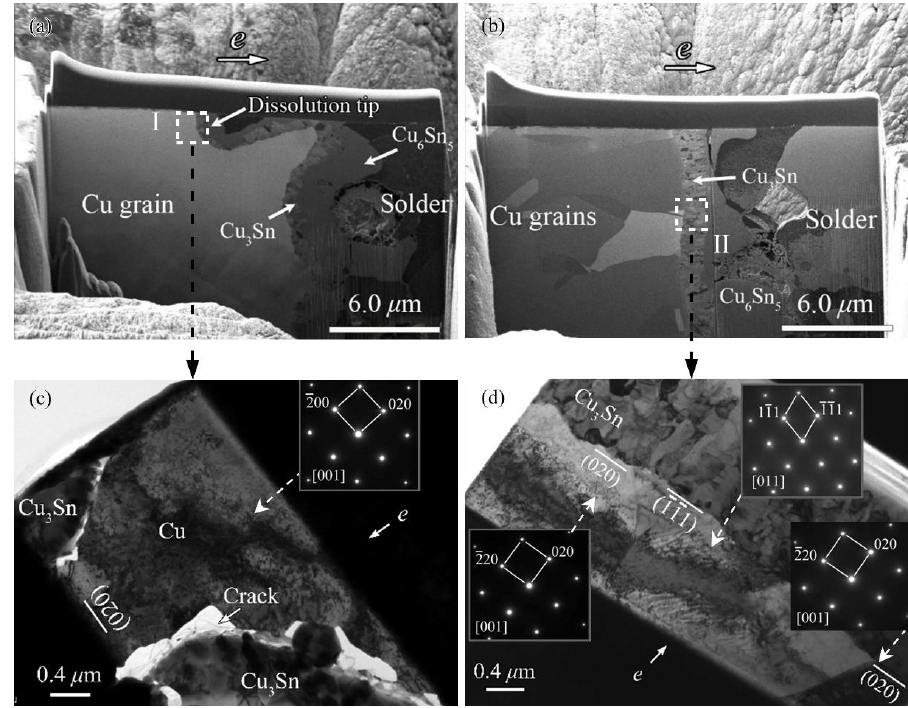
Figure 3. FIB/BSE images of internal cross-sectional view around the dissolution tip ( a ) and the nondissolution tip ( b ), and bright field images and selected-area diffraction patterns of copper grains adjacent to the cathodic Cu/IMC interface: ( c ) at ‘I’ in Figure 3a and ( d ) at ‘II’ in Figure 3b, with the inserts showing the diffraction patterns of the corresponding copper grains.